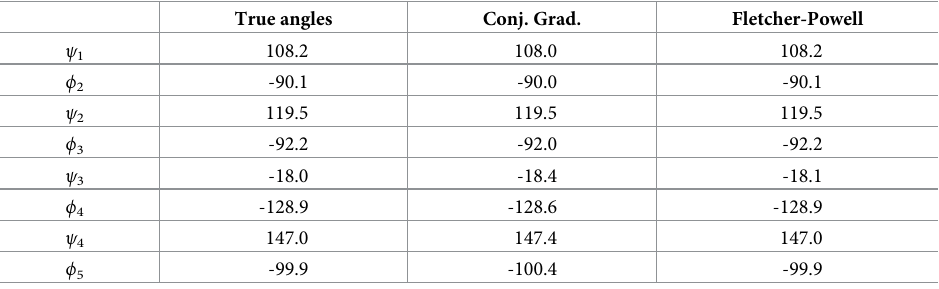
Table 2. Predicted and actual angles. True angles Conj.